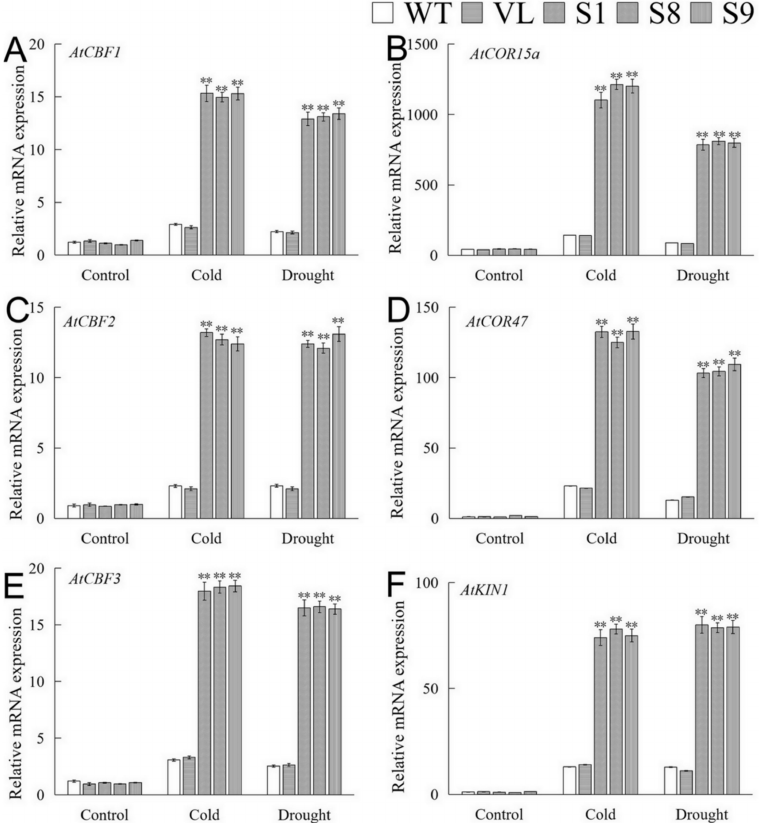
Figure 9. Analysis of downstream gene expression of MbICE1 in WT, VL (vector line), and overexpression- MbICE1 under drought and cold stresses. Relative expression level of ( A ) AtCBF1 ; ( B ) AtCOR15a ; ( C ) AtCBF2 ; ( D ) AtCOR47 ; ( E ) AtCBF3 ; ( F ) AtKIN1 by q-PCR. The value is the average of three repeats, and the standard deviation is represented by the error bar. The asterisk indicates the difference compared to WT (** p ≤